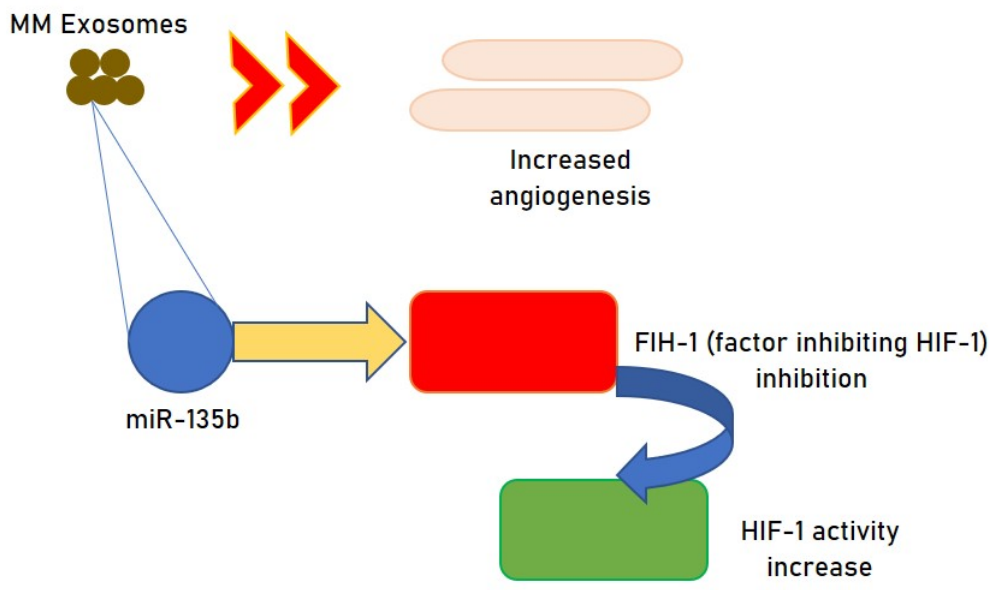
Figure 3. Hypoxic exosomes promote angiogenesis in MM.